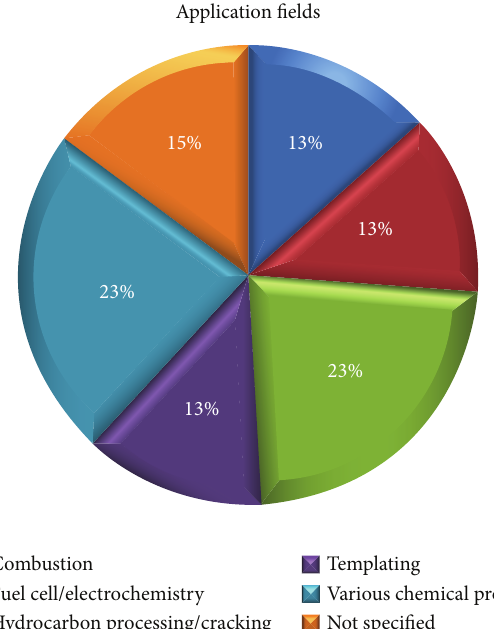
Figure 5: Application fields of patents related to nanocatalysis